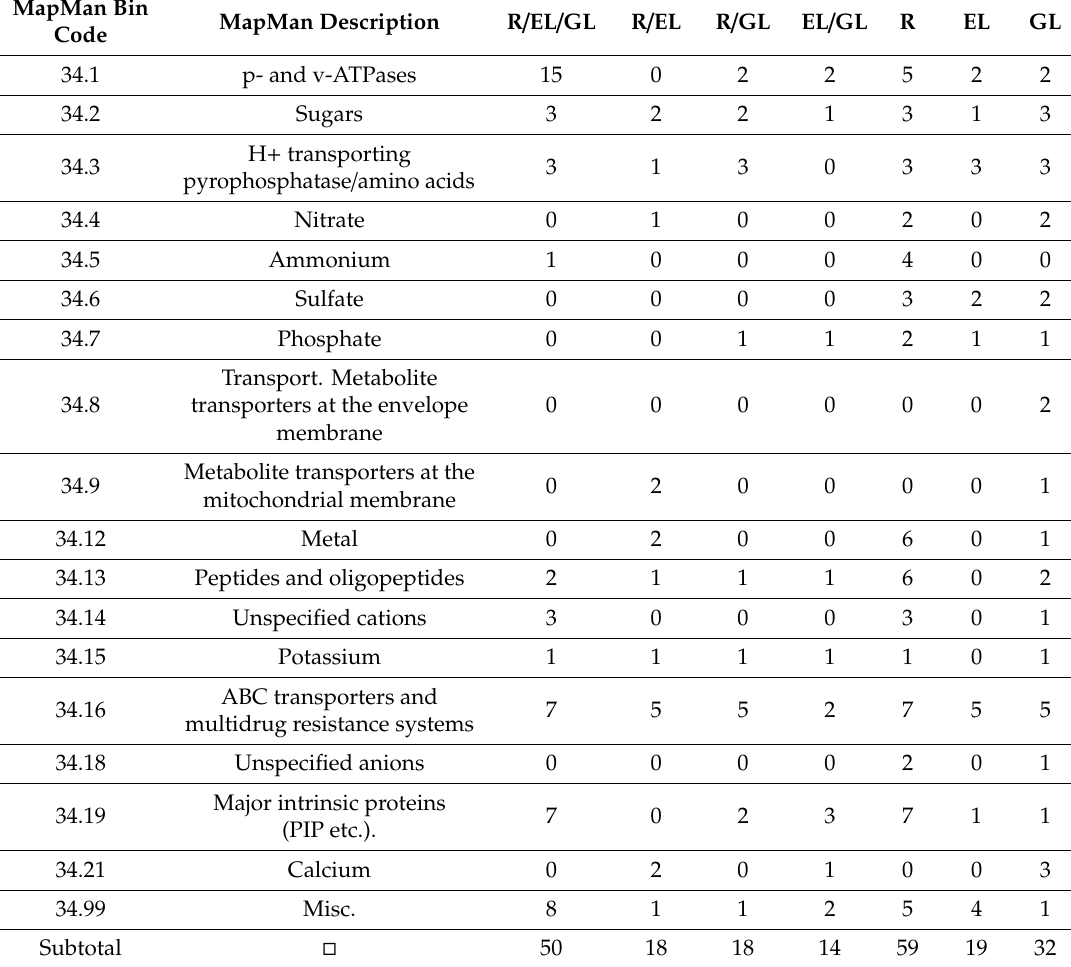
Table 1. Number of proteins, which are grouped into category “transport” using the MapMan analysis, among plasma membrane proteins of the root (R), etiolated leaf (EL), and green leaf (GL). MapMan Bin